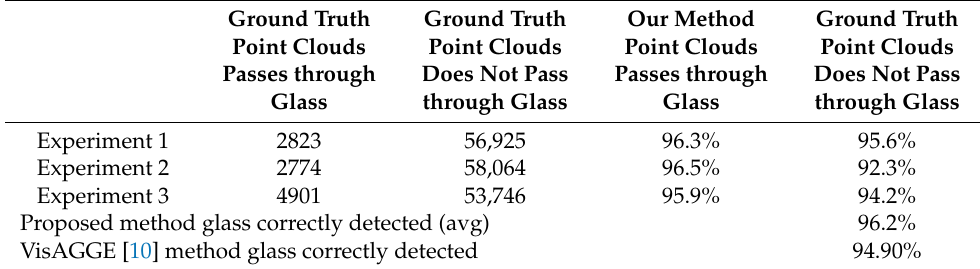
Table 1. Result of glass